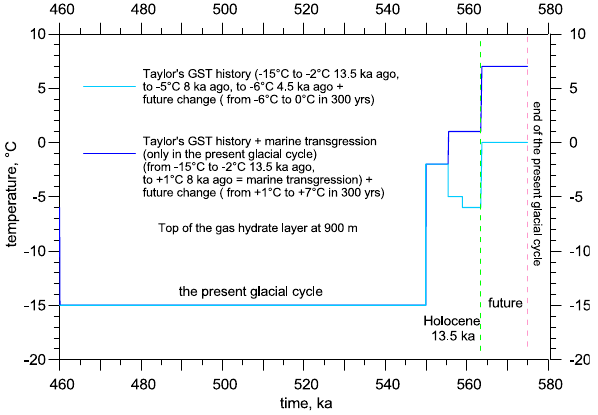
Fig. 12. Changes in the onshore and offshore (Holocene marine transgression) GH and IBP during the present glacial cycle including the possible future warming (see Fig.11) in its end induced by a doubling of atmospheric CO2 content. The Holocene starts at time 550 ka of the simulations and the present time is 563.5 ka.